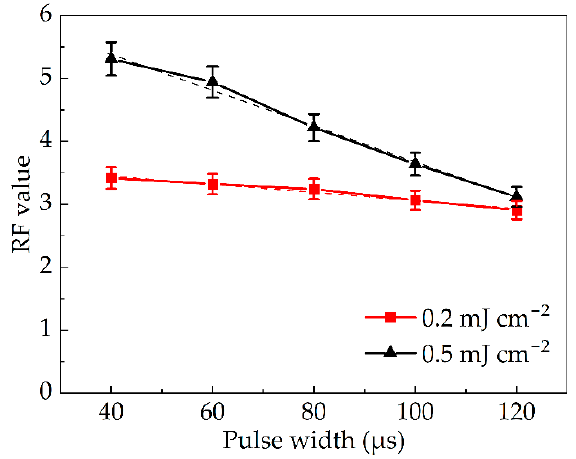
Figure 5. Dependence of RF value on pulse width at the same single-pulsed dose.